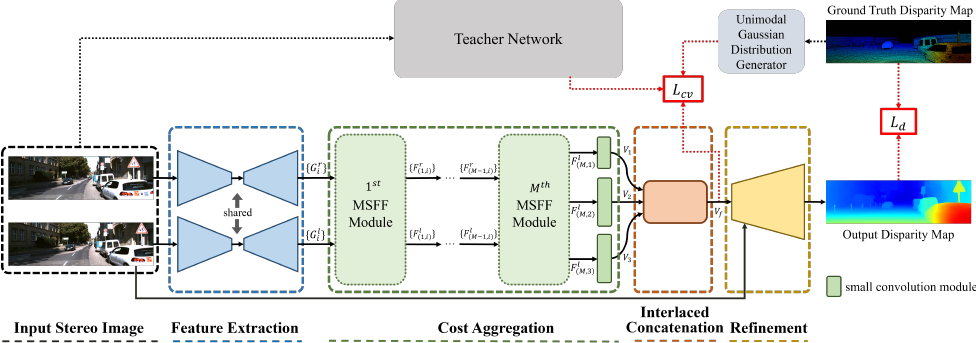
Figure 2. An overview of the proposed method. A path using dotted arrows is required only for the training